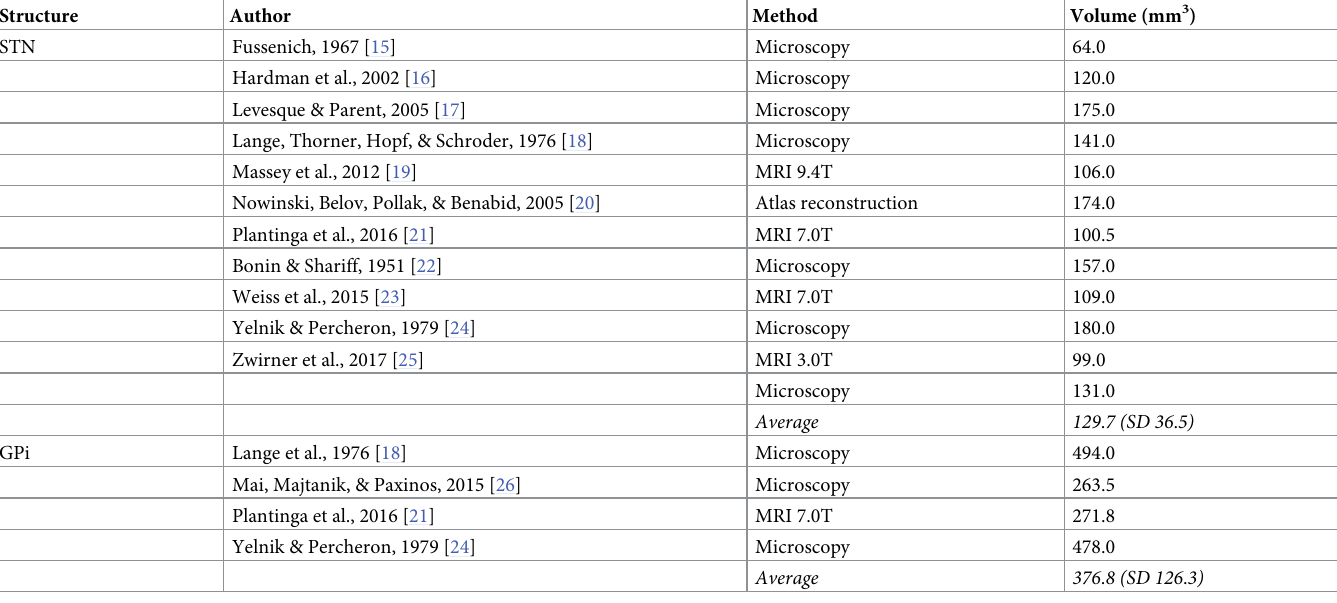
Table 1. Post mortem hemispheric volume estimates for a number of deep brain stimulation targets. STN : subthalamic nucleus; GPi : globus pallidus internal segment .